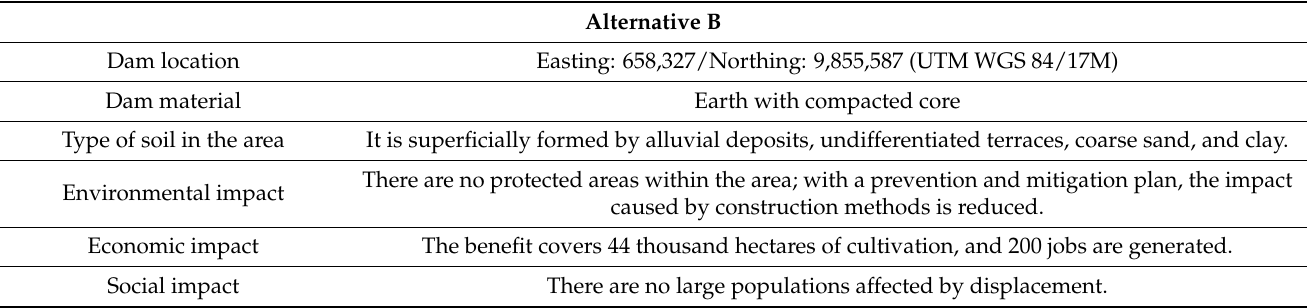
Table 6. Main characteristics of the alternative chosen in the